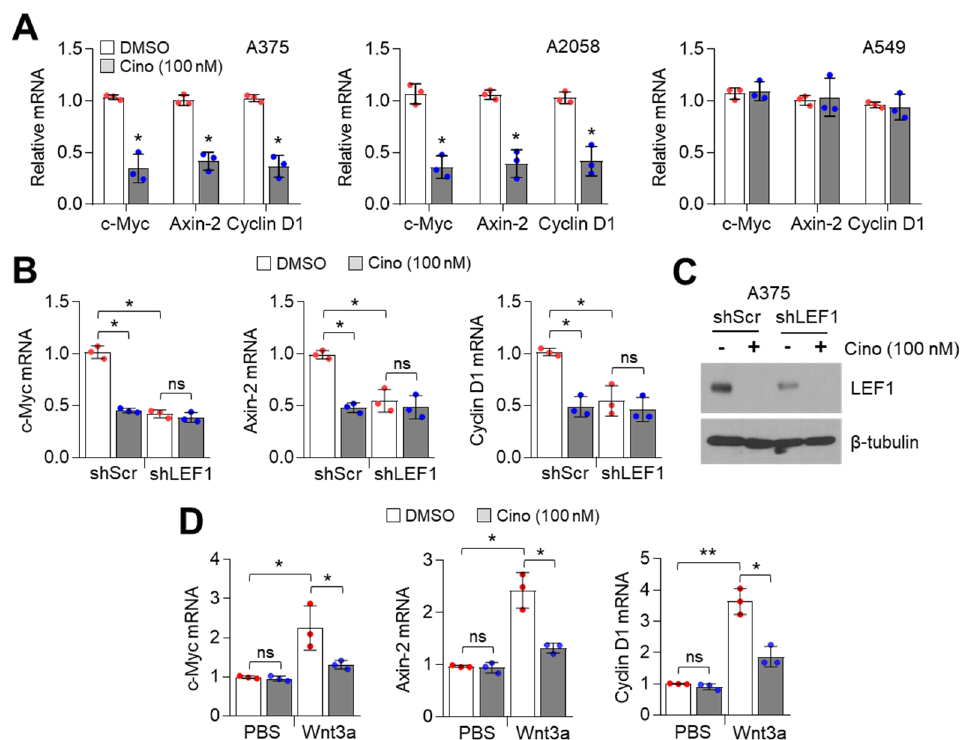
Figure 4. Cinobufagin suppresses expression of β -catenin / TCF4-induced target genes in melanoma cells. ( A ) β -catenin / TCF4 target genes decreased by cinobufagin in LEF1-high expressing melanoma cells, but not LEF1-low expressing A549 lung cancer cells. Cells were incubated with cinobufagin for 24 h. After cinobufagin treatment, gene expression levels were measured by qRT-PCR. The values represent the mean ± SD ( n = 3); * p < 0.05. ( B ) β -catenin / TCF4 target genes are not responsive to cinobufagin in LEF1 knocked-down A375 cells. Cinobufagin was treated for 24 h in LEF1 knocked-down A375 cells. β -catenin / TCF4 target genes expression levels were measured by qRT-PCR. The values represent the mean ± SD ( n = 3); * p < 0.05 and ns, not significant. ( C ) LEF1 knock-down e ffi ciency in A375 cells. LEF1 protein levels were measured by Western blotting. ( D ) Wnt3a-induced β -catenin / TCF4 target genes are decreased by cinobufagin in human melanocytes. Recombinant Wnt3a protein was dissolved in 1X PBS containing 0.1% endotoxin-free HSA. Wnt3a (30 ng / mL) pretreated for 1h prior to cinobufagin treatment, and then cells were incubated for 24 h. β -catenin / TCF4 target genes expression levels were measured by qRT-PCR. The values represent the mean ± SD ( n = 3); * p < 0.05 and ** p < 0.01. ns, not significant. Red and blue points, mean value of individual sample.